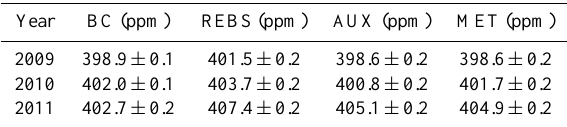
Table 1. The annual regional CO 2 mole fractions by the four meth- ods from 2009 to 2011.